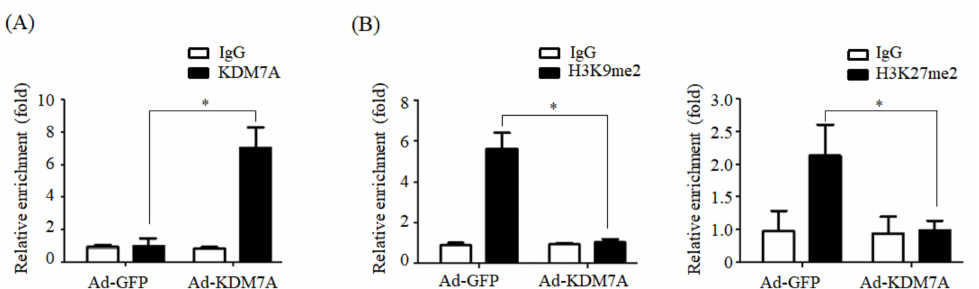
Figure 4. KDM7A overexpression reduces the enrichment of H3K9me2 and H3K27me2 on DGAT2 promoter. AML12 cells were infected with adenovirus Ad-GFP or Ad-KDM7A and ChIP-PCR was performed. ( A ) The recruitment of KDM7A to the DGAT2 promoter was analyzed by ChIP-qPCR. ( B ) The enrichment of H3K9me2 and H3K27me2 on the promoter of DGAT2 was analyzed by ChIP-qPCR. Data are presented as the mean ± SD from three independent experiments. * p < 0.05 vs. control